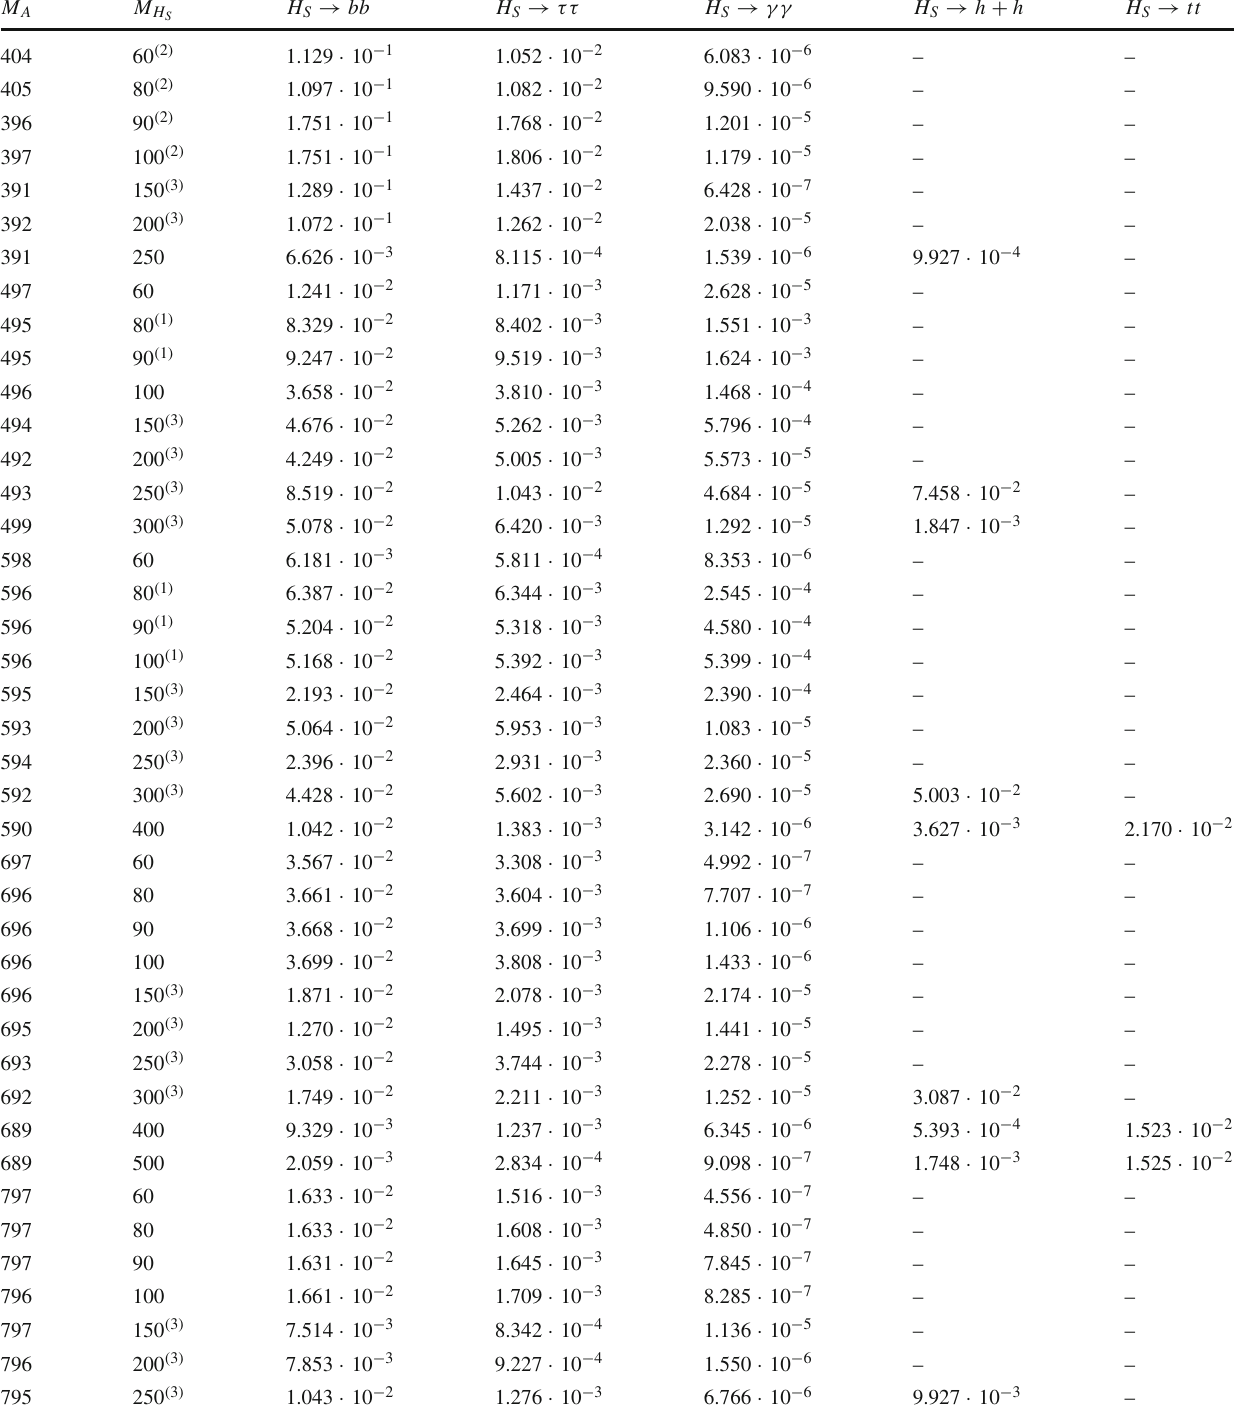
Table 4 Possible cross sections (in pb) at 13 TeV for ggF → A